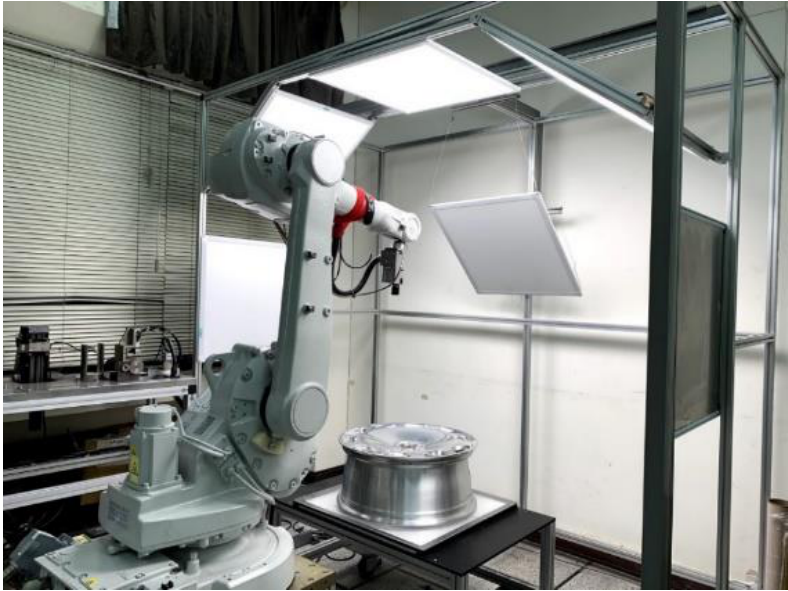
Figure 1. Photographic image showing a practical implementation of the proposed system.